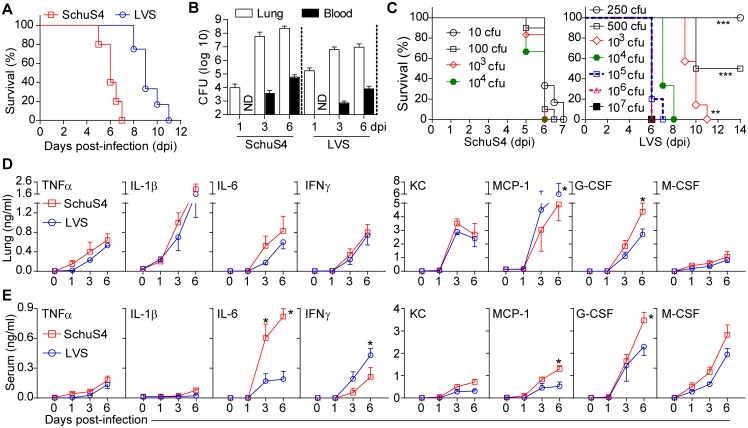
Mortality, bacterial burden, and cytokine kinetics in pulmonary tularemia.(A) Survival of Ft SchuS4 (10 cfu) or Ft LVS (1000 cfu) infected C57BL/6 mice (% survival of three independent experiments). (B) Lung and blood bacterial burden in Ft infection (mean ± SD of three independent experiments; the bacterial burden at all days post-infection (dpi) was significantly (p<0.001) different from the initial inoculum of 10 cfu (SchuS4) or 1000 cfu (LVS) at 0 dpi, ANOVA with Tukey’s post-test). (C) Survival with escalating Ft numbers (mean % survival of two independent experiments, Log-rank (Mantel-Cox) test, **p<0.01 and ***p<0.001 indicate difference from 105−107 cfu groups). (D) Cytokine and chemokine levels in lungs and (E) serum (mean ± SD of two (SchuS4, n = 6 mice) or three (LVS, n = 9 mice) independent experiments, Student’s t-test, *p<0.05 represents differences between SchuS4 and LVS strains at indicated dpi. In panels B, D and E, for SchuS4 infection at 6 dpi, ~50% of the mice had died and only the remaining live mice (n = 6) were used for analysis. As previous studies have demonstrated that most of these cytokines are significantly induced at or after 3 dpi, statistics for differences in cytokine induction at various dpi following SchuS4 or LVS infection are unmarked.